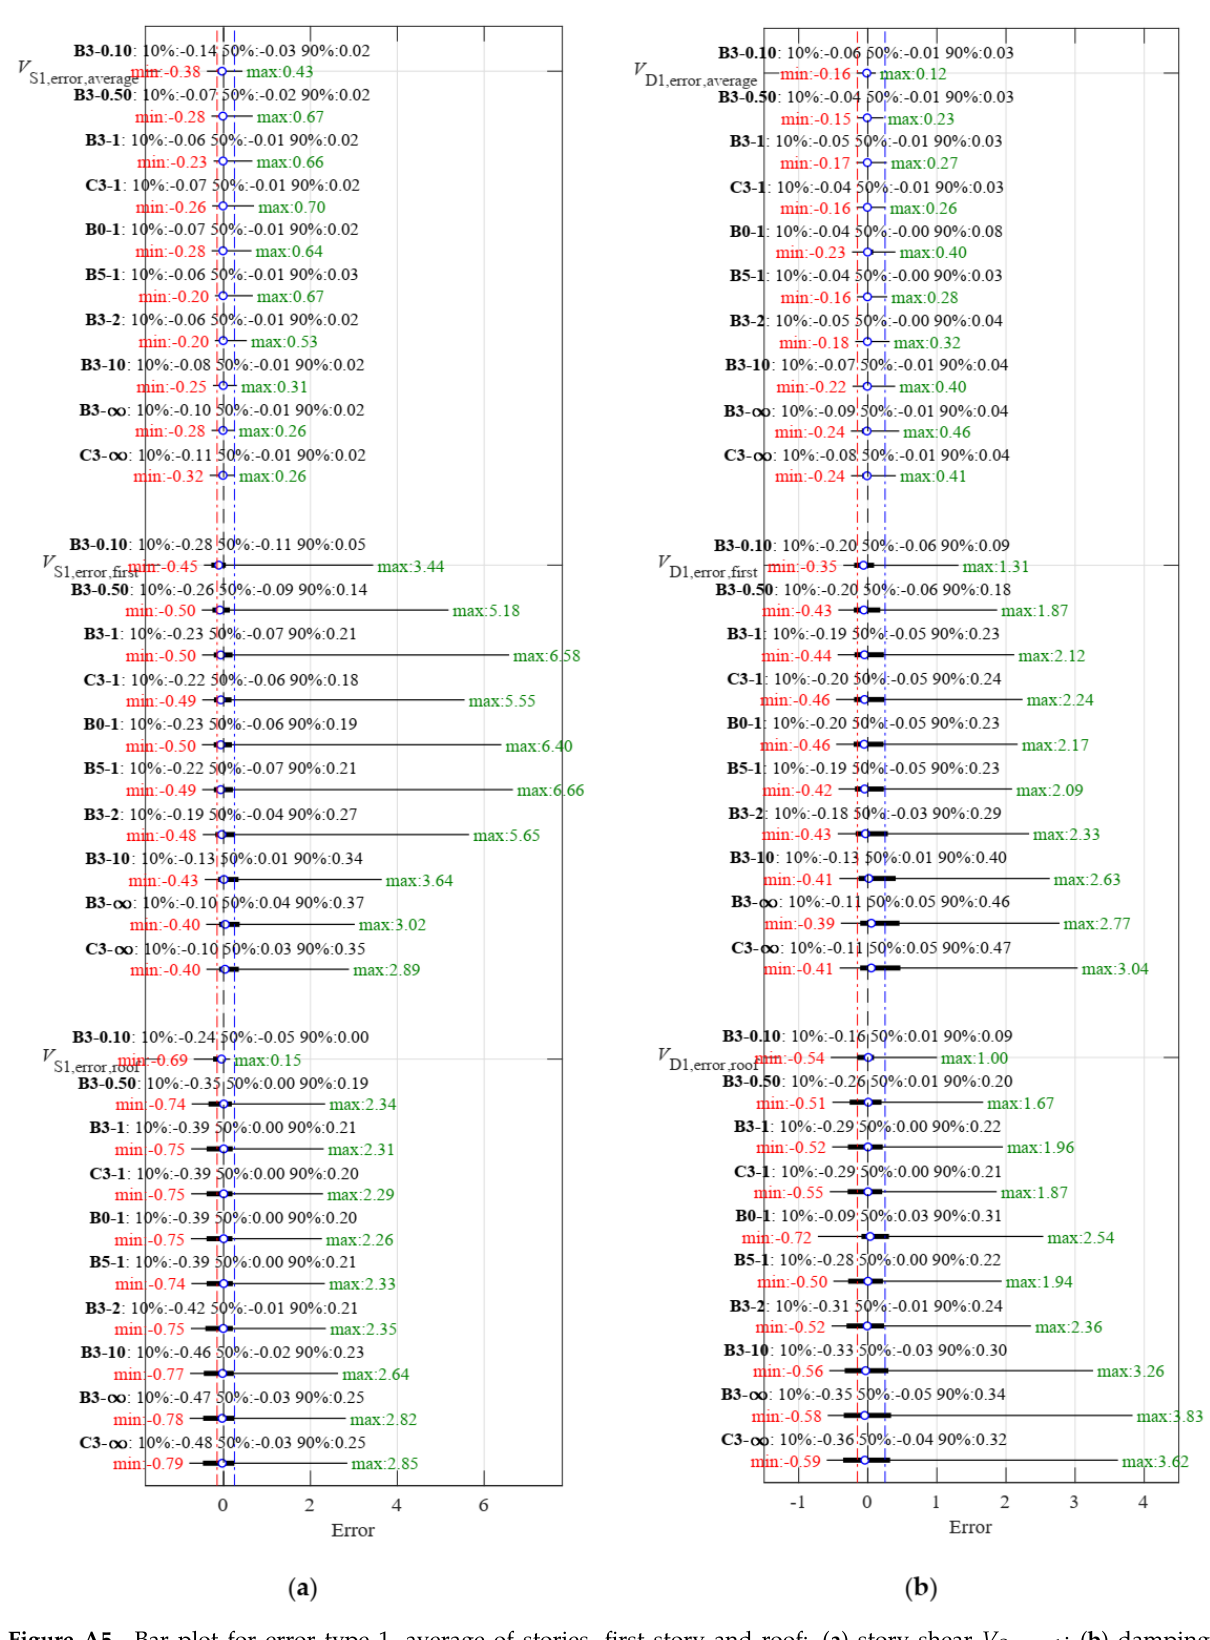
Figure A5. Bar plot for error type 1, average of stories, first story and roof: ( a ) story shear V S,error,1 ; ( b ) damping shear V D,error,1